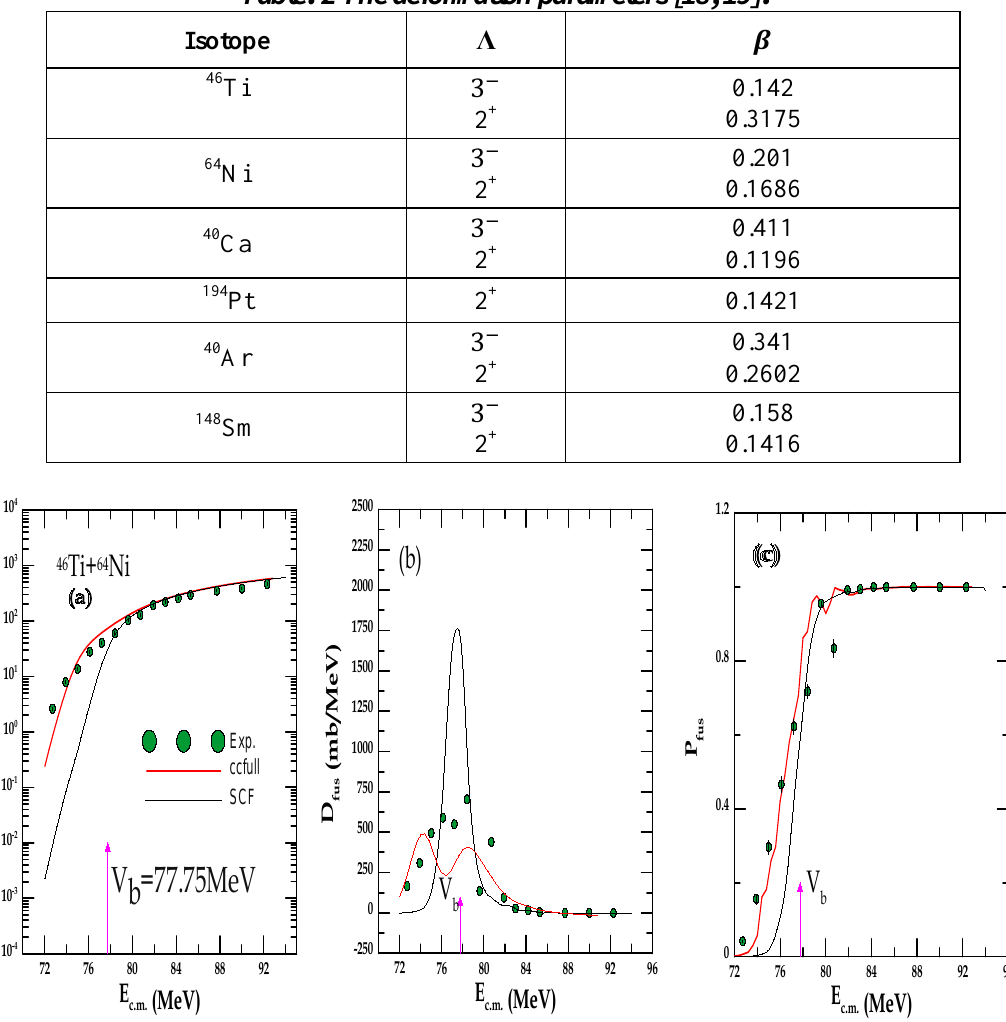
Fig. 1: (a) The cross section of fusion, (b) the distribution of fusion barrier and (c) the probability of fusion for the system 46 Ti+ 64 Ni (red curve represent the quantum mechanical calculations, black curve represents the semi-classical calculations, green circles are experimental data [17], the barrier position indicated by magenta arrow on the E